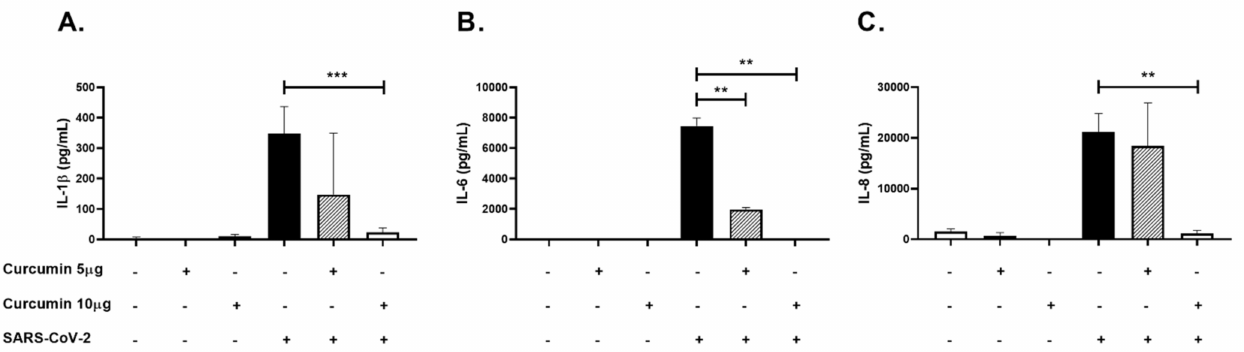
Figure 9. Anti-inflammatory effect of curcumin in PBMCs stimulated with SARS-CoV-2. Inflammatory cytokines were quantified in PBMCs supernatants by ELISA. The figure represents the concentrations of ( A ) IL-1 β , ( B ) IL-6, and ( C ) IL-8. Cells untreated were used as a negative control. Data were represented as median ± IQR (n = 6). Mann–Whitney test ** p ≤ 0.01, *** p ≤